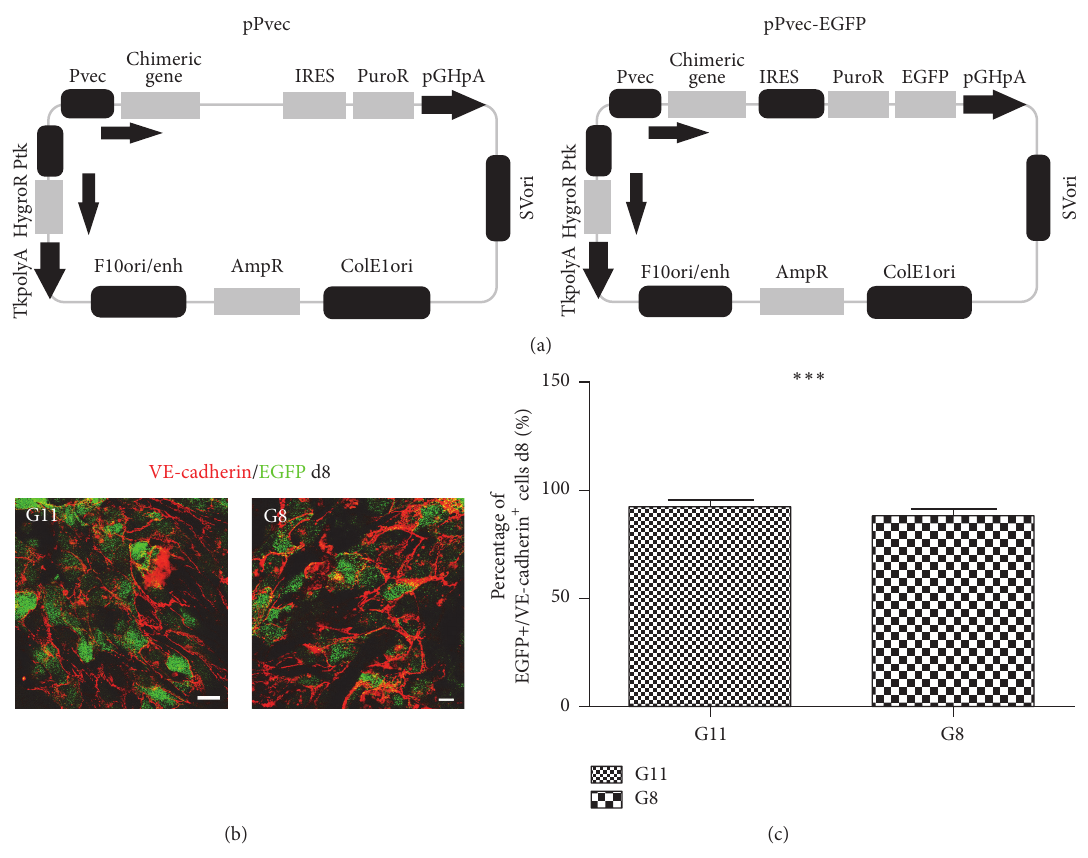
Figure 1: Generation and characterization of genetically modified ES clones expressing puromycin resistance gene under Pvec. (a) Schematic representationofepisomalconstructspPvecandpPvec-EGFP,usedforgenerationofESclones.(b)ThemajorityofVE-cadherin + cellsexpress EGFP in EBs derived from clones G11 and G8 at d8. (c) Statistical analysis of the percentage of VE-cadherin + cells coexpressing EGFP at d8 from three independent experiments. For each experiment ∼ 600 VE-cadherin + cells were counted. ∗∗∗ 𝑃 < 0.001 . Scale bar: 20 𝜇